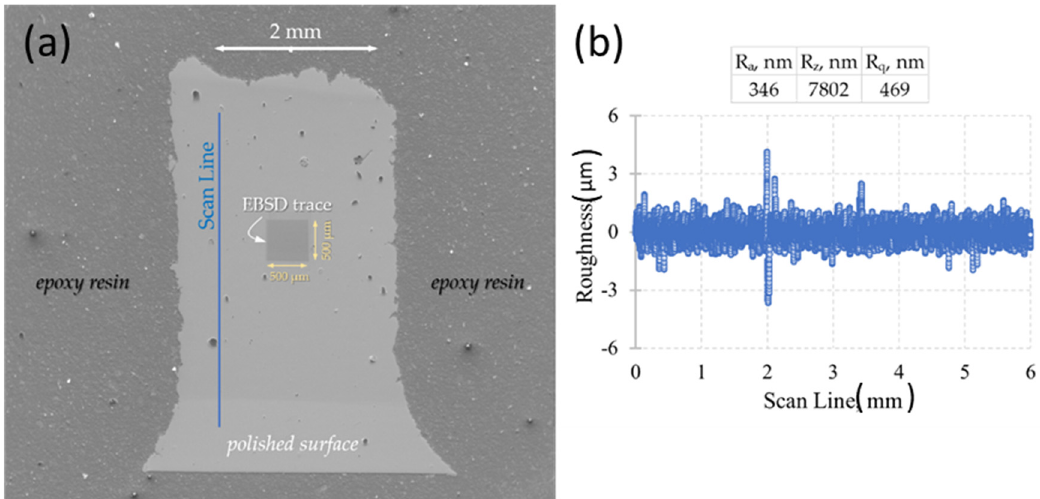
Figure 2. General view of a polished surface for EBSD and nanoindentation measurements ( a ) and roughness estimation for the indicated scan line ( b ).